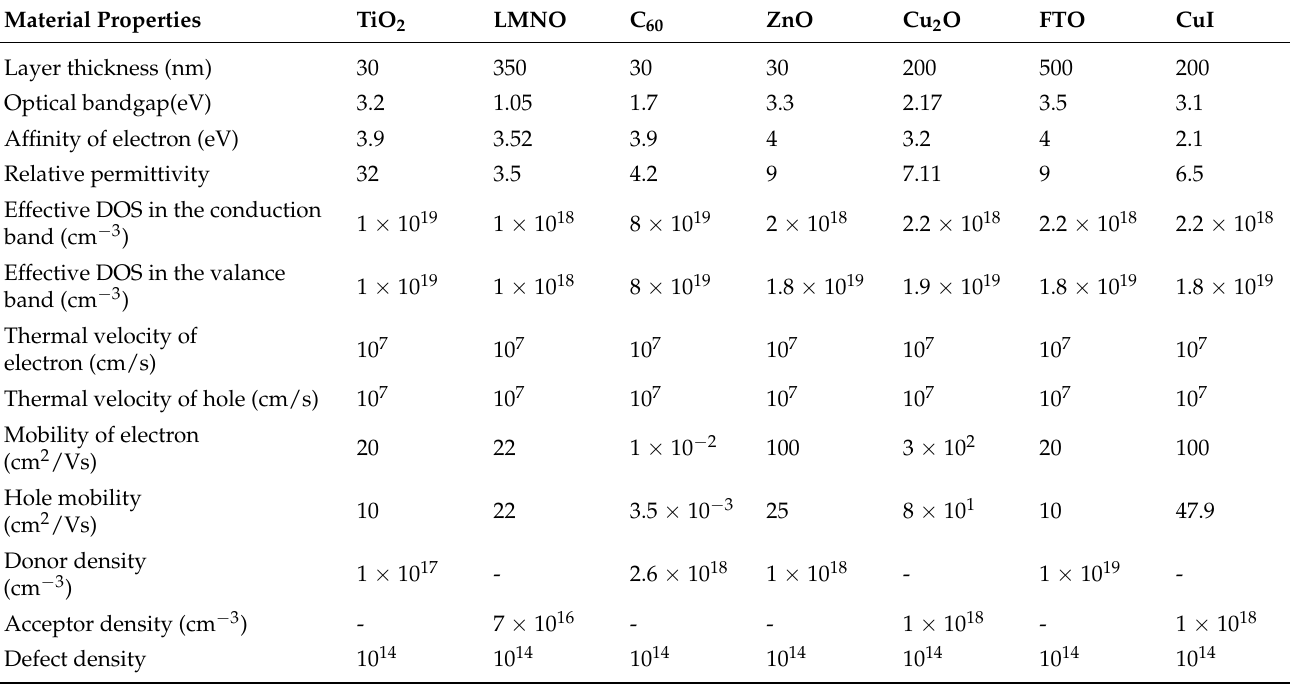
Table 1. Parameters of different